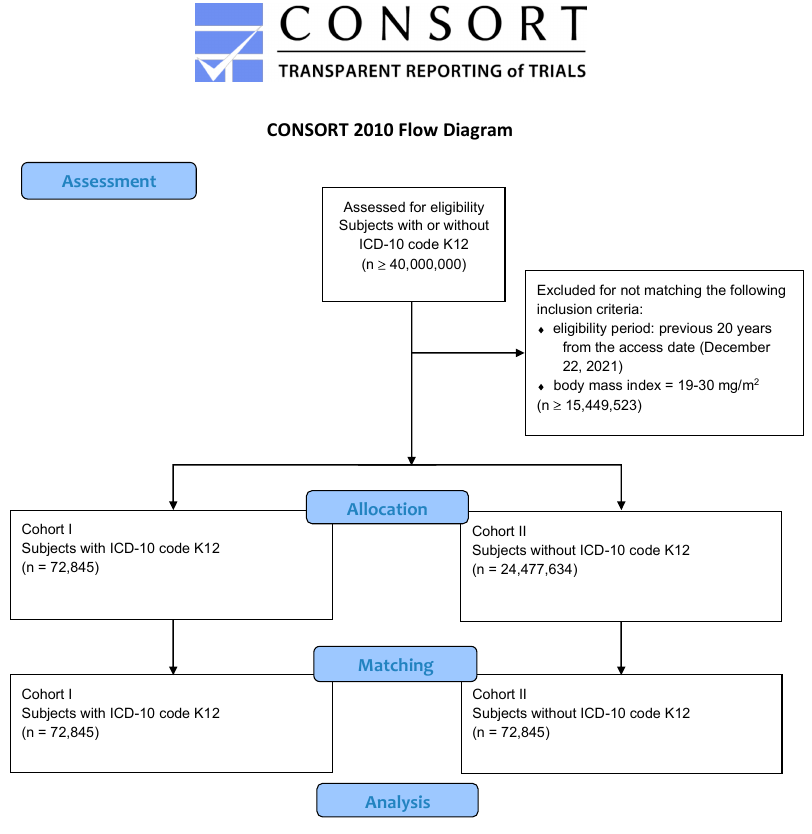
Figure 1. Modified CONSORT flow chart. Note: the number of eligible subjects was ≥ 40,000,000, which is above the analysis capacity of TriNetX. As a consequence, additional inclusion criteria were necessary to restrict the enclosure of patients.